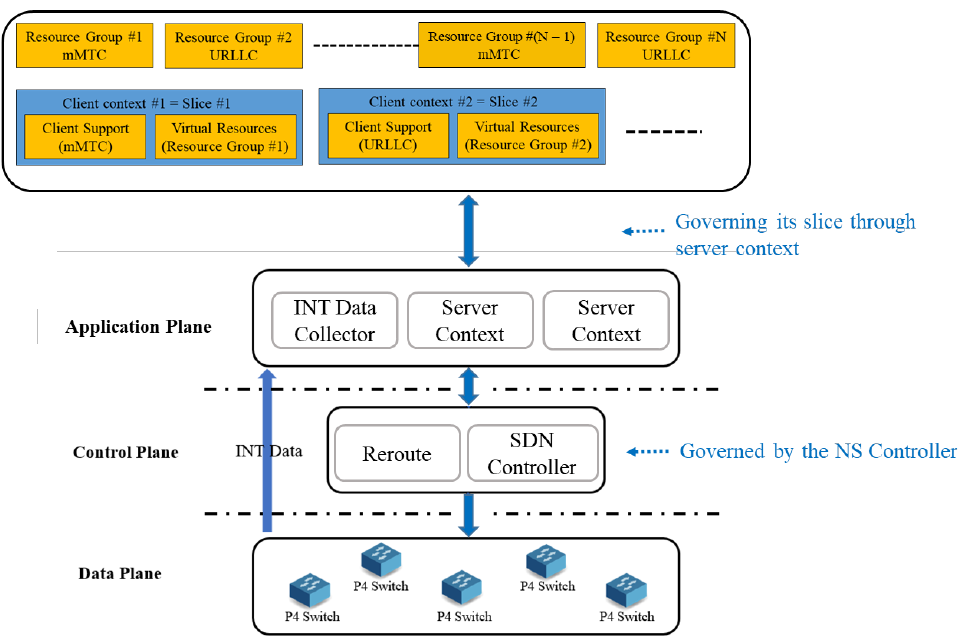
Figure 5. SDNPS framework.